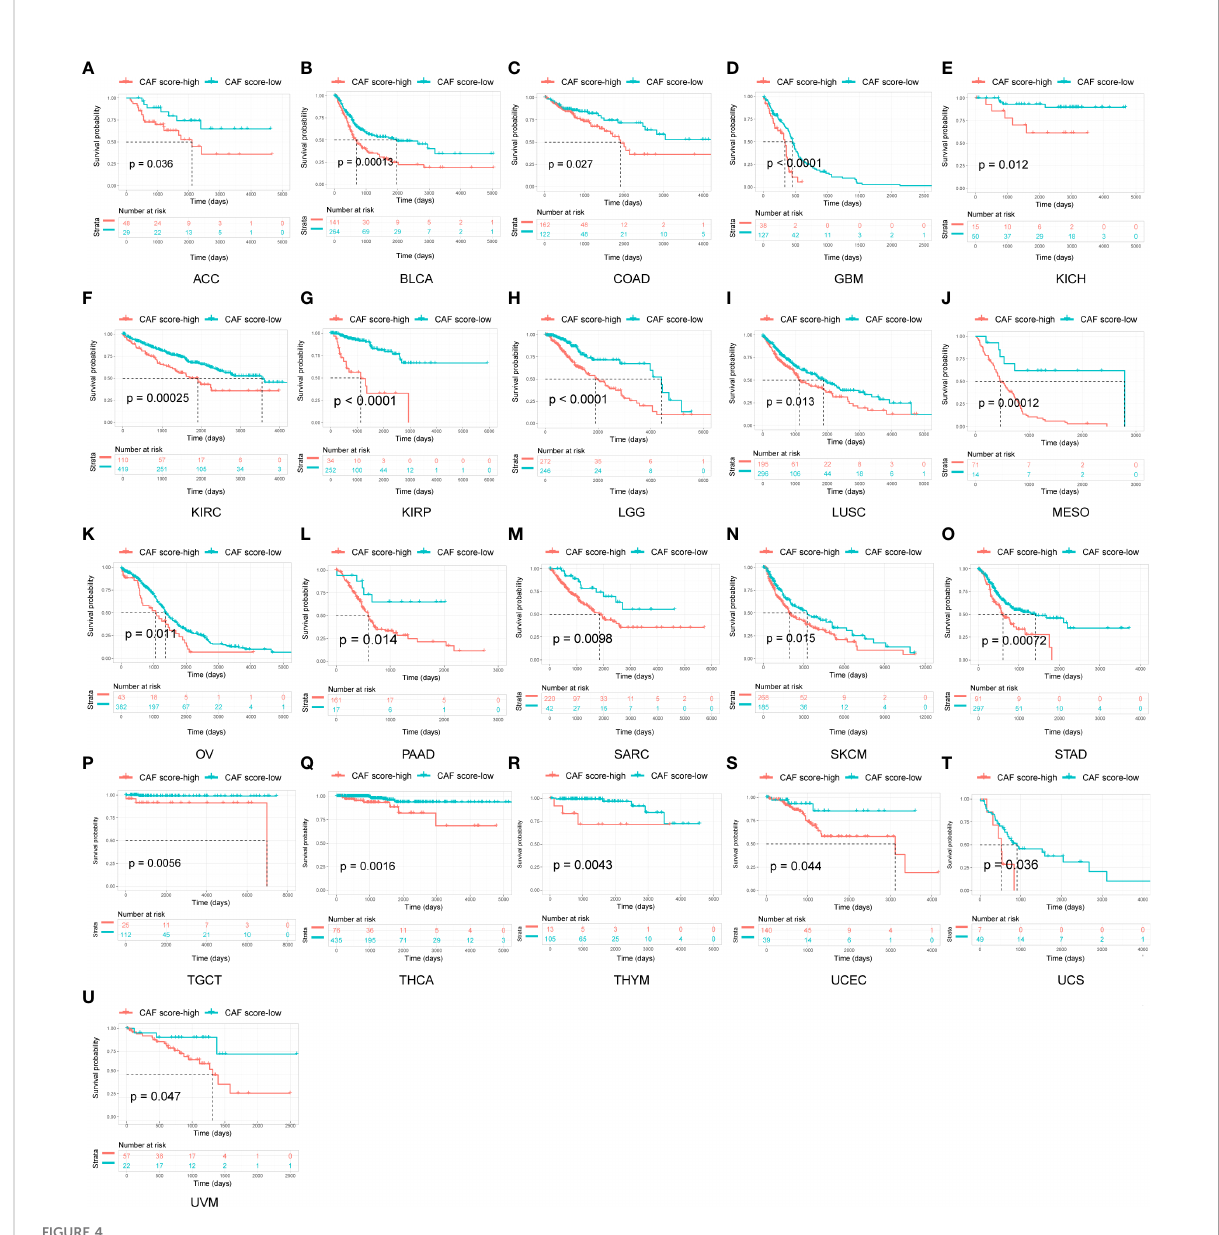
FIGURE 4 Survival analysis between CAF score group and overall survival in pan-cancer. Only signi fi cant results were